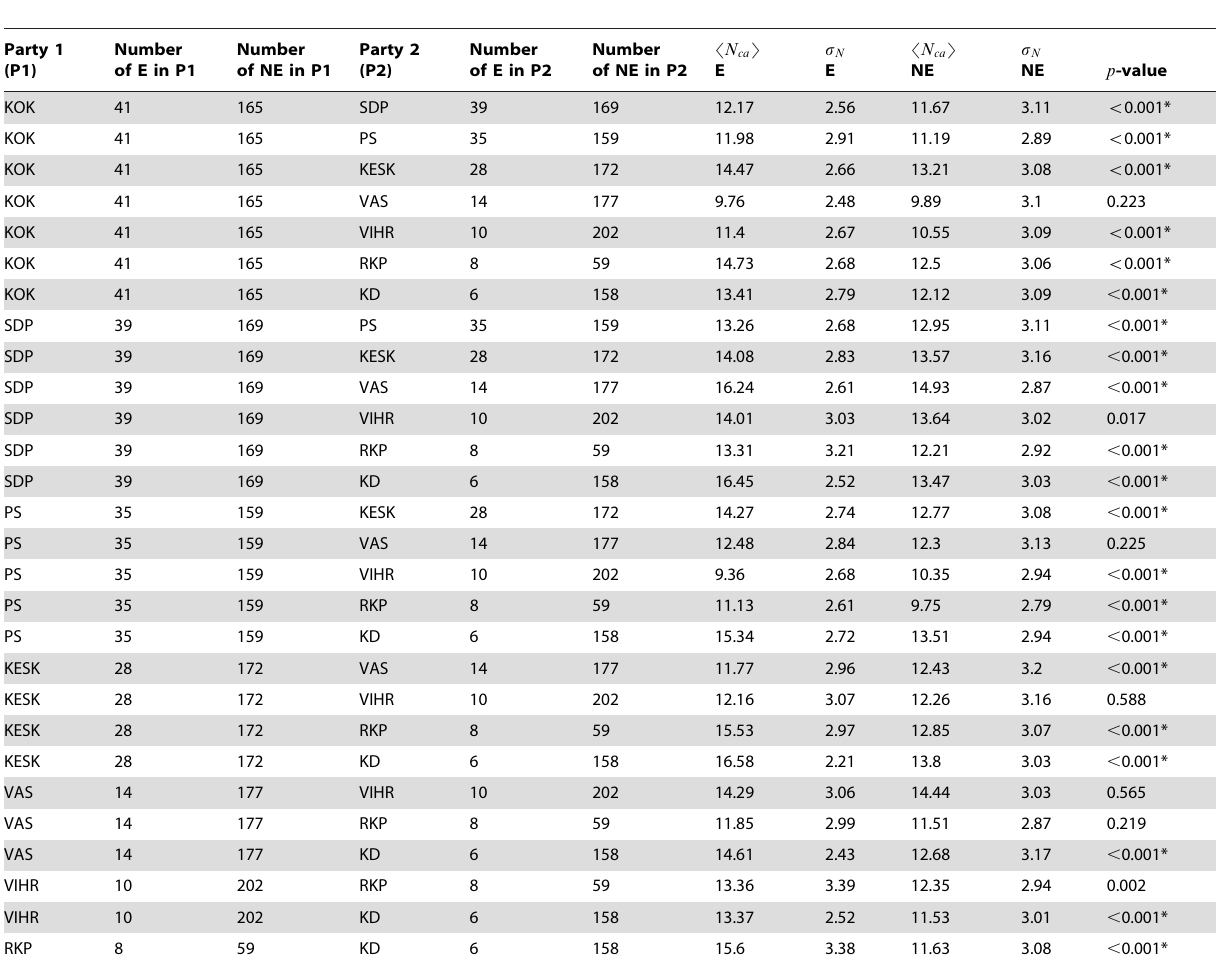
Table 5. Summary statistics of the inter-party average number of common answers S N ca T present in the political profile of elected (E) and non-elected (NE) candidates, disaggregated by pairs of